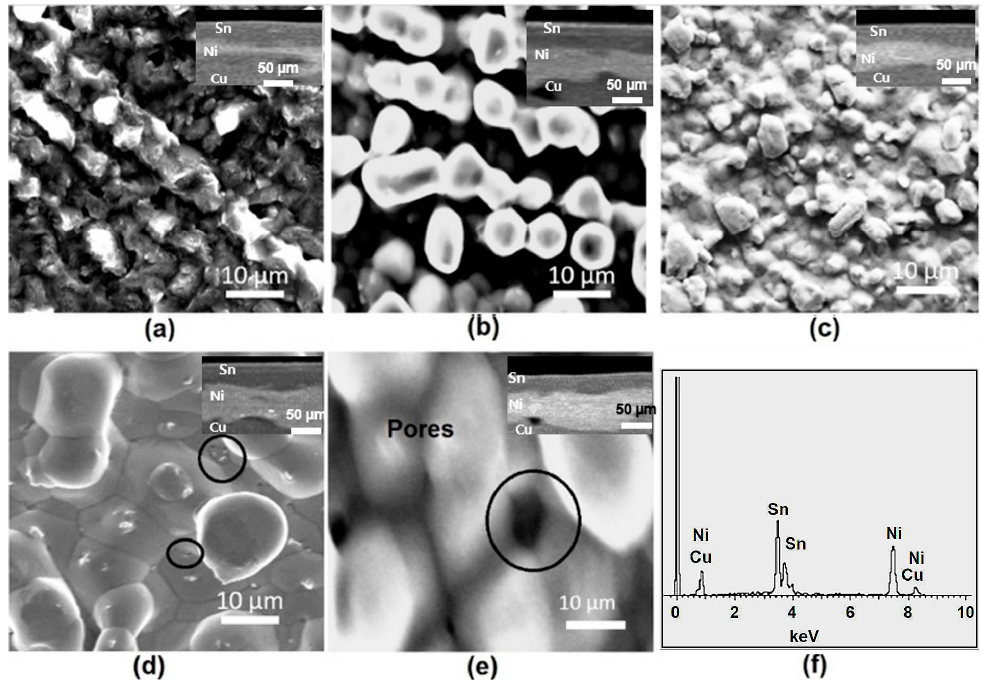
Figure 4. Surface morphology of Sn-plated Ni at different current densities: ( a ) 100, ( b ) 200, ( c ) 300, ( d ) 400, and ( e ) 500 mA/cm 2 . The EDS spectrum of ( c ) is shown in ( f ). The inset shows the corresponding cross-section images. The black circles in (d and e) represent the pores in the coatings.